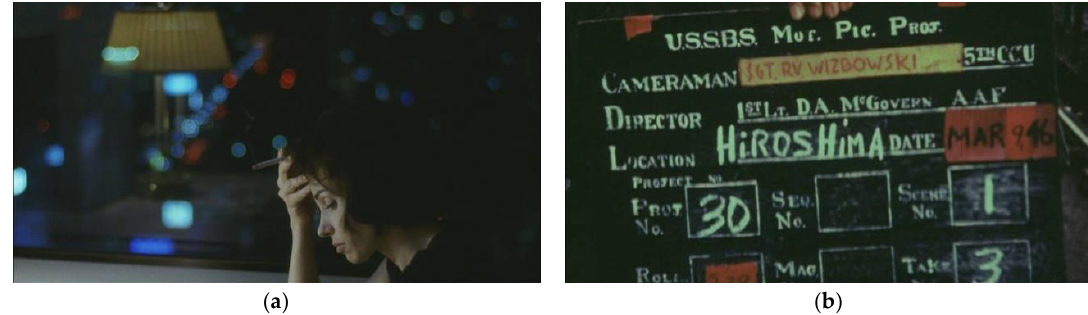
Figure 4. Frames from H Story . A shot of Béatrice Dalle drinking alone ( a ) is followed by a sequence of archive images from the Hiroshima bombings ( b ). Source: DVD edition by Cinéma Indépendant (France).